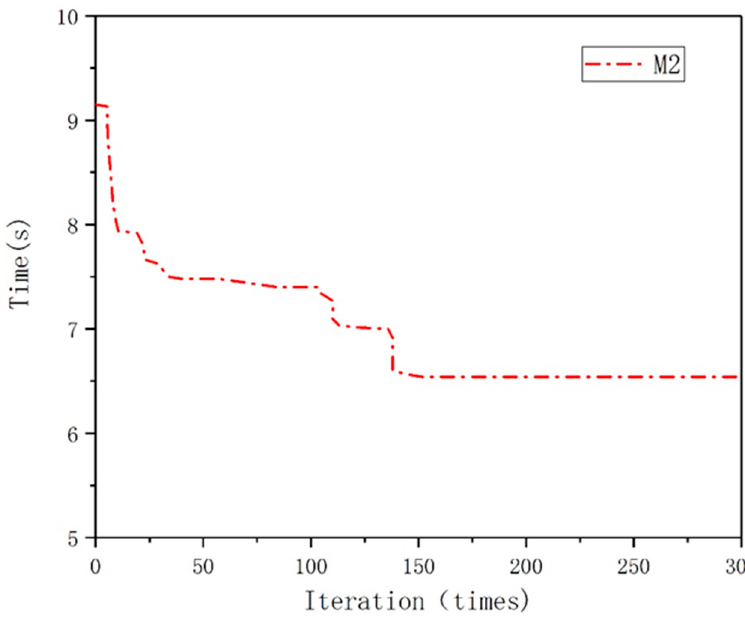
Figure 8. Time iterative curve of drilling machine.